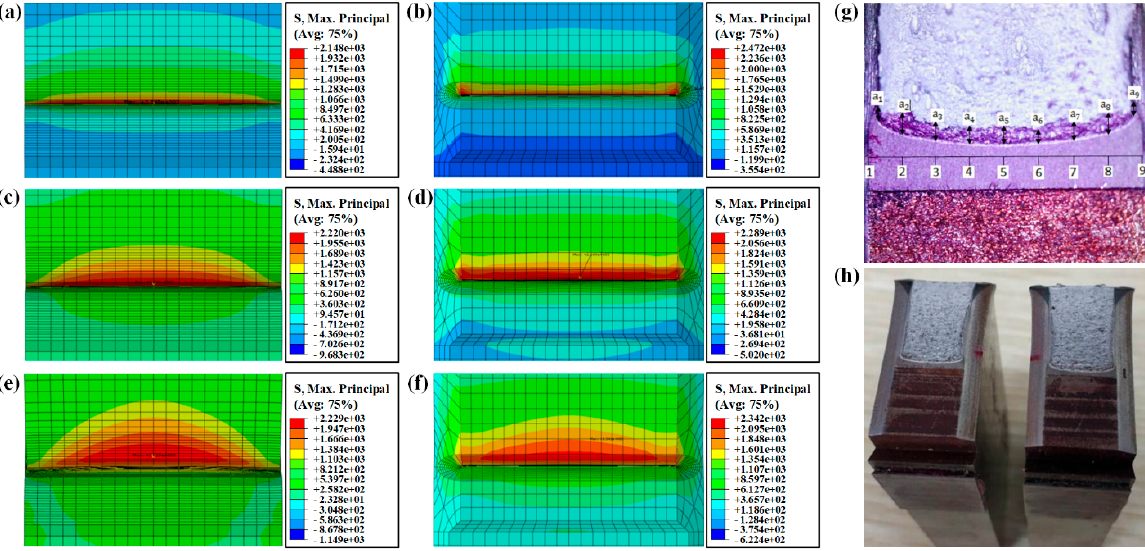
Figure 9. Stress distribution on the crack surface of the specimens SENB20 without side grooves and SENB20 with side grooves at different times: ( a ) SENB20 without side grooves at t 1 time; ( b ) SENB20 with side grooves at t 1 time; ( c ) SENB20 without side grooves at t 2 time; ( d ) SENB20 with side grooves at t 2 time; ( e ) SENB20 without side grooves at t 3 time; ( f ) SENB20 with side grooves at t 3 time; ( g ) experiment result of SENB20 without side grooves; ( h ) experiment result of SENB20 with side grooves.